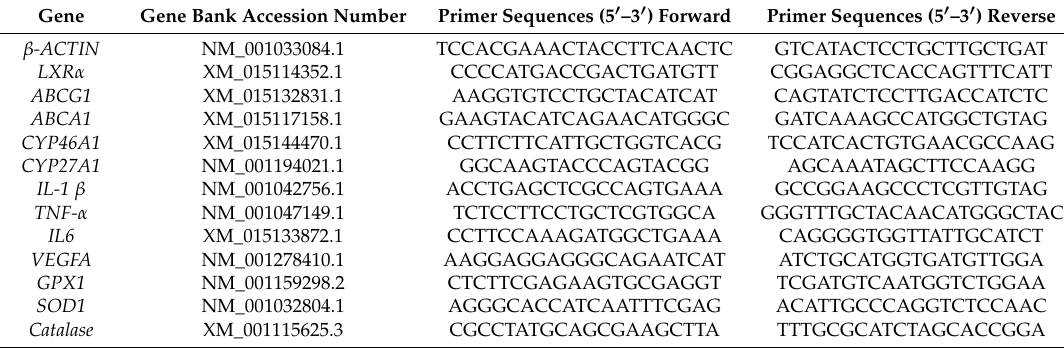
Table 1. Primers used for